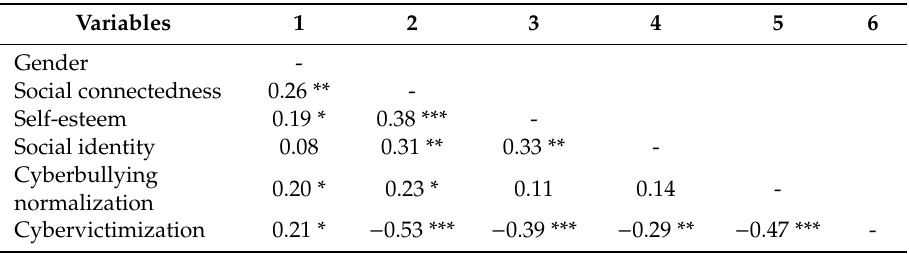
Table 2. Correlations of all the study’s